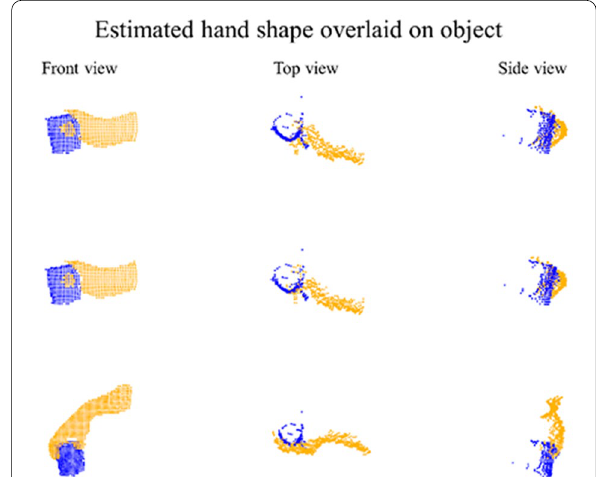
Fig. 11 Point cloud of the object and recalled grasping hand for the second object in Fig. 10. The object and hand points being represented by blue and yellow